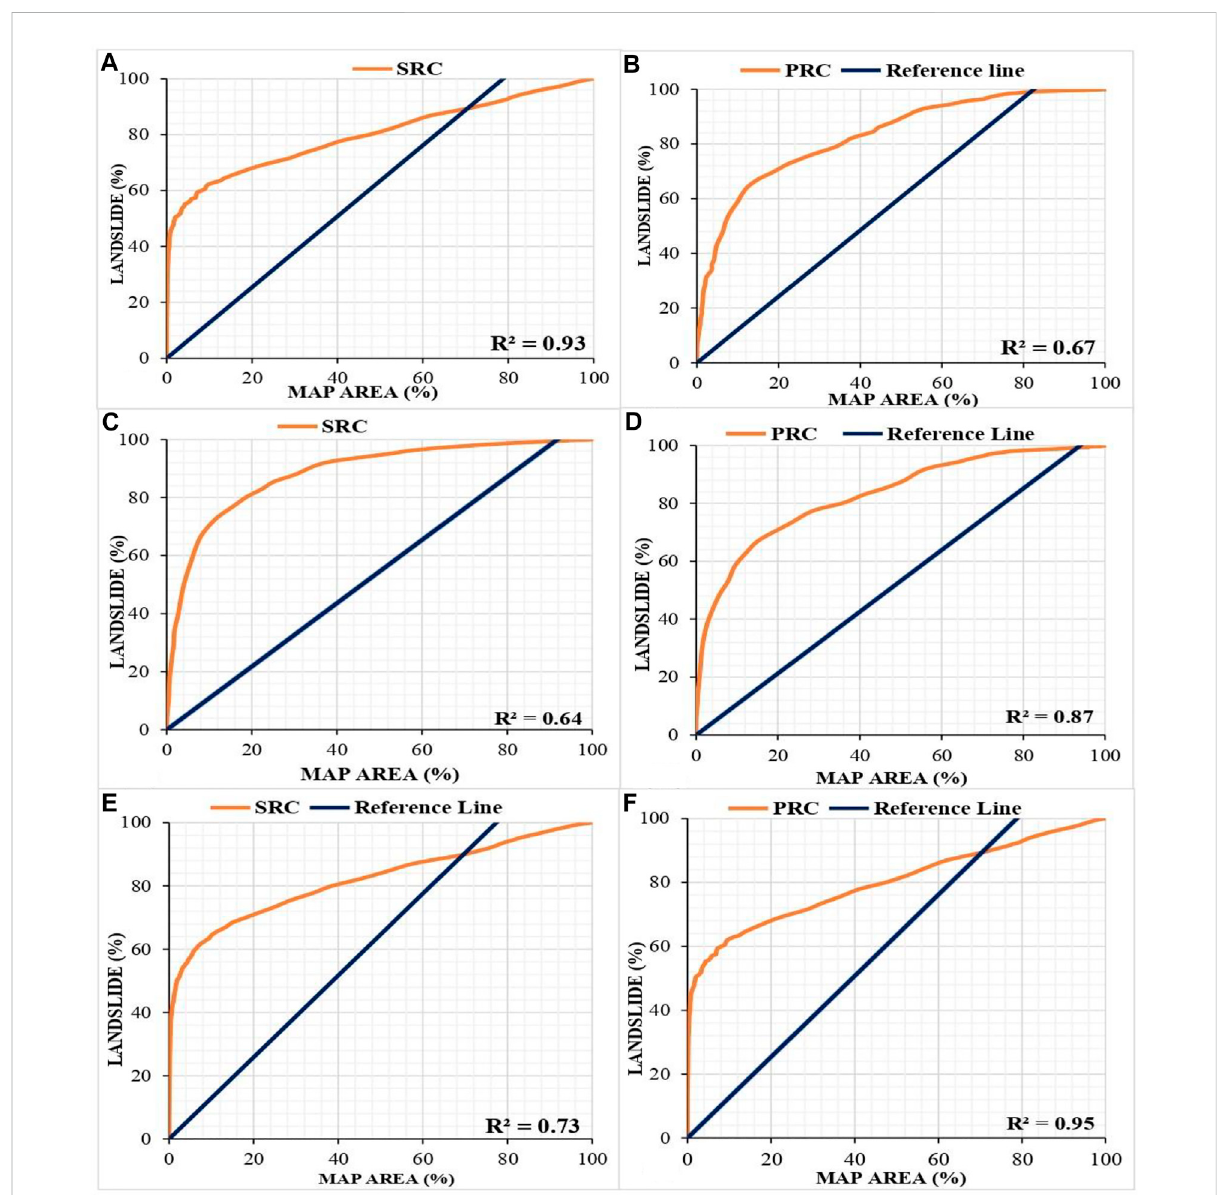
FIGURE 7 Success rate curve (SRC) and predicted rate curve (PRC) for WOE, FR, and IV model: (A) SRC for WOE; (B) PRC for WOE; (C) SRC for FR model; (D) PRC for FR model; (E) SRC for IV; (F) PRC for